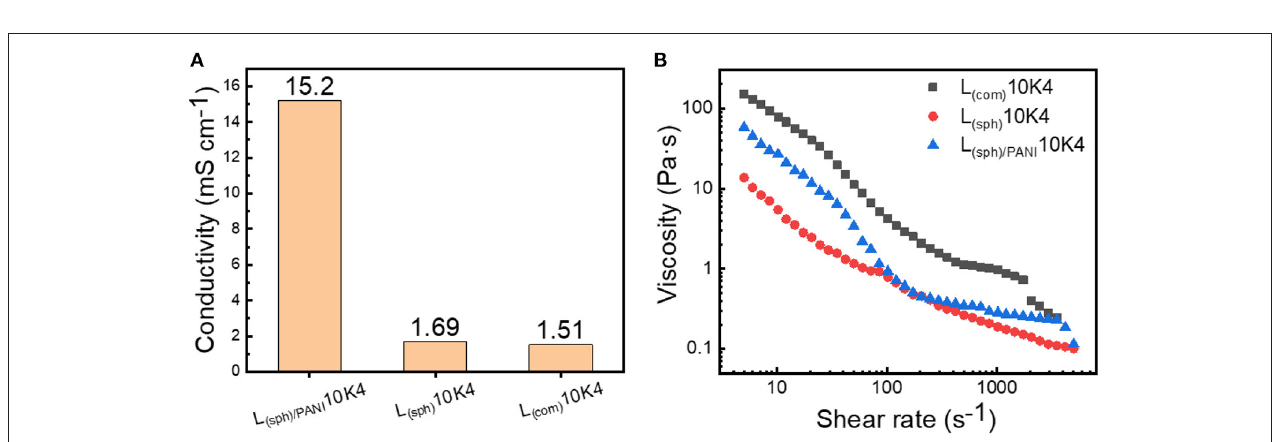
FIGURE 4 | (A) Electronic conductivity and (B) viscosity curves of the L (sph) / PANI 10K4, L (sph) 10K4, and L (com) 10K4 suspensions.